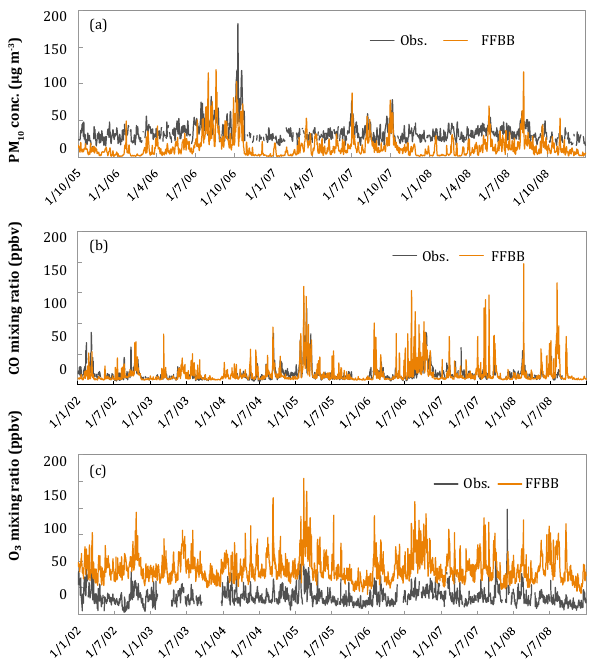
Figure 3. (a) Time series of daily surface PM 10 (µgm − 3 ; AQI de- rived) from the ground-based observations (black line) and FFBB- simulated results (orange line) in Kuala Lumpur, Malaysia, during October 2005–December 2008. (b) Time series of daily surface CO mixing ratio (ppbv) from the ground-based observations (black line) and FFBB-simulated results (orange line) in Bukit Kototabang, In- donesia, during 2002–2008. (c) Same as (b) but for surface O 3 .